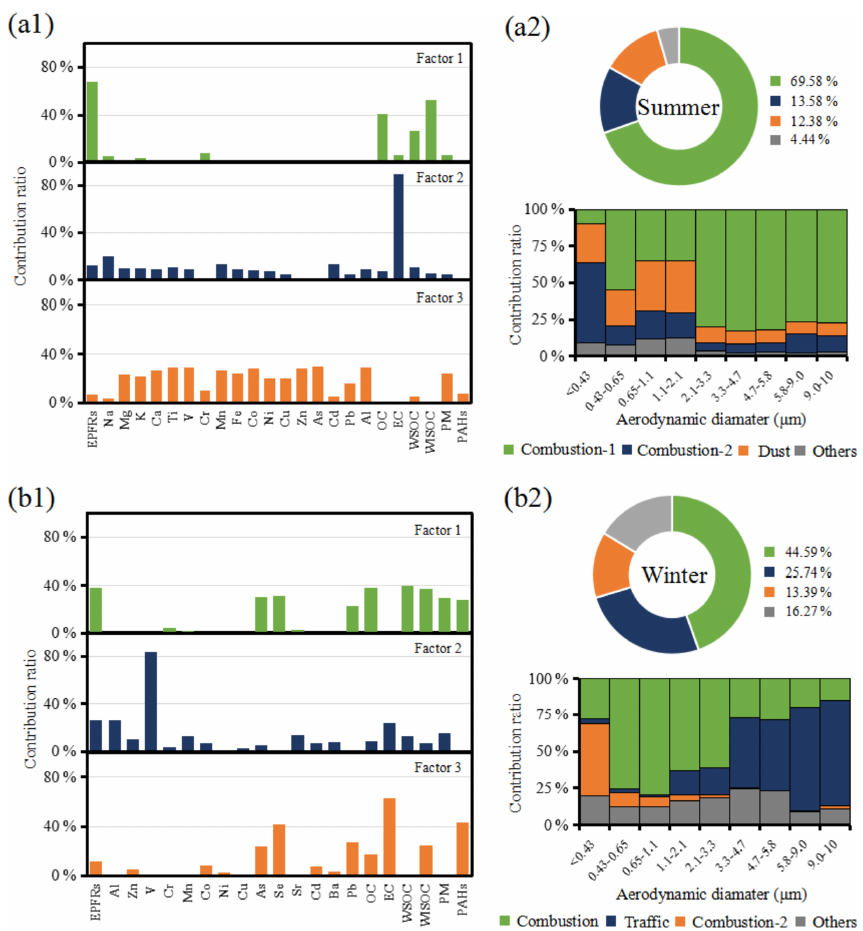
Figure 3. Factor analysis of EPFRs in different particle sizes in different seasons. Panels (a1) and (b1) represent the results of factor analysis for summer and winter, respectively. Panels (a2) and (b2) represent the contribution of various factors in summer and winter, respectively, to EPFRs and the relative contributions of each factor for different particle